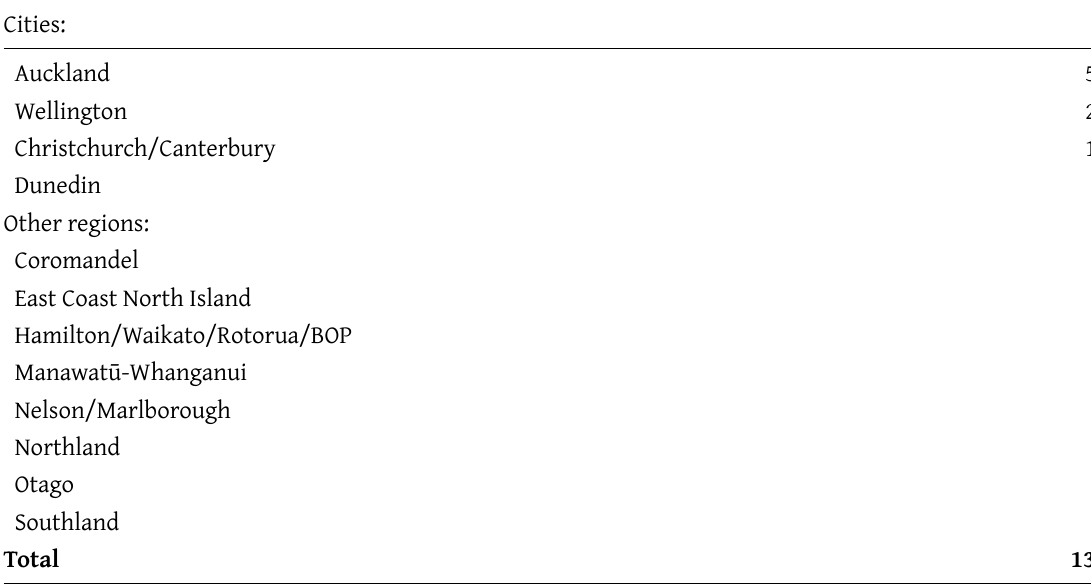
Table 7: Geographical Distribution of Buddhist Organizations,